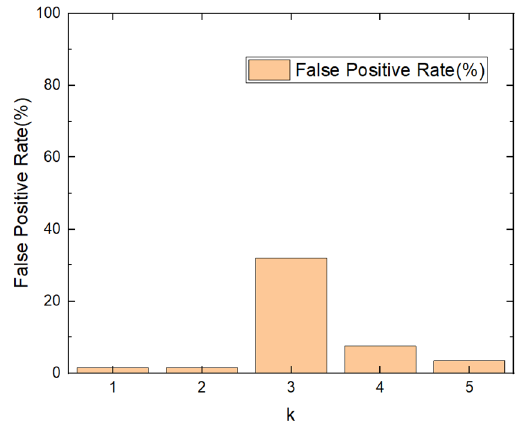
Figure 11. False Positive Rate.